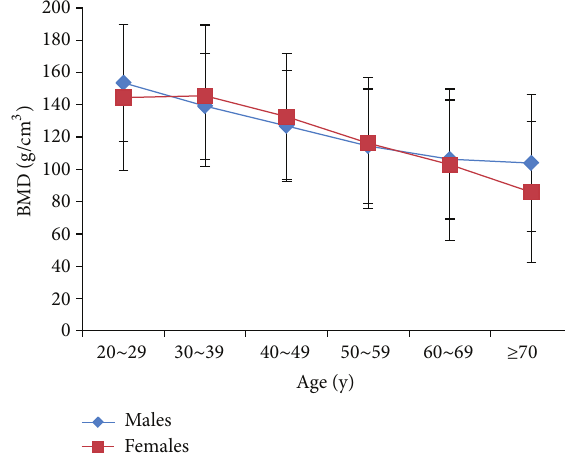
Figure 1: Bone mineral density (in grams per cubic centimeter) changes associated with age for males and females derived by QCT